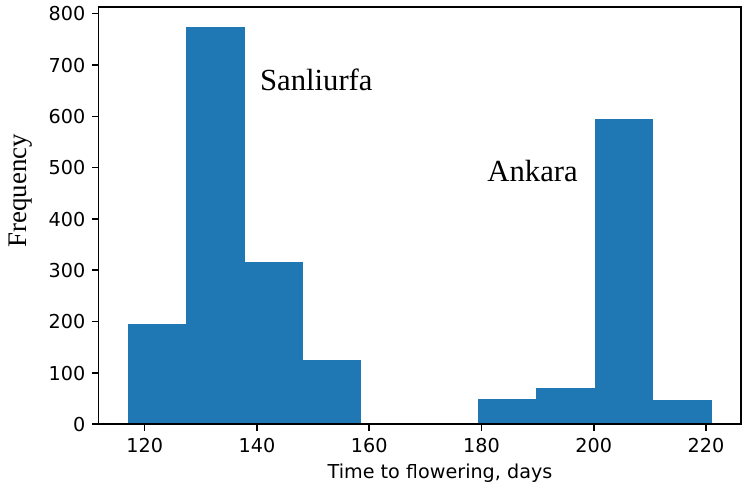
Figure 2. Histogram of time to flowering for autumn-sown